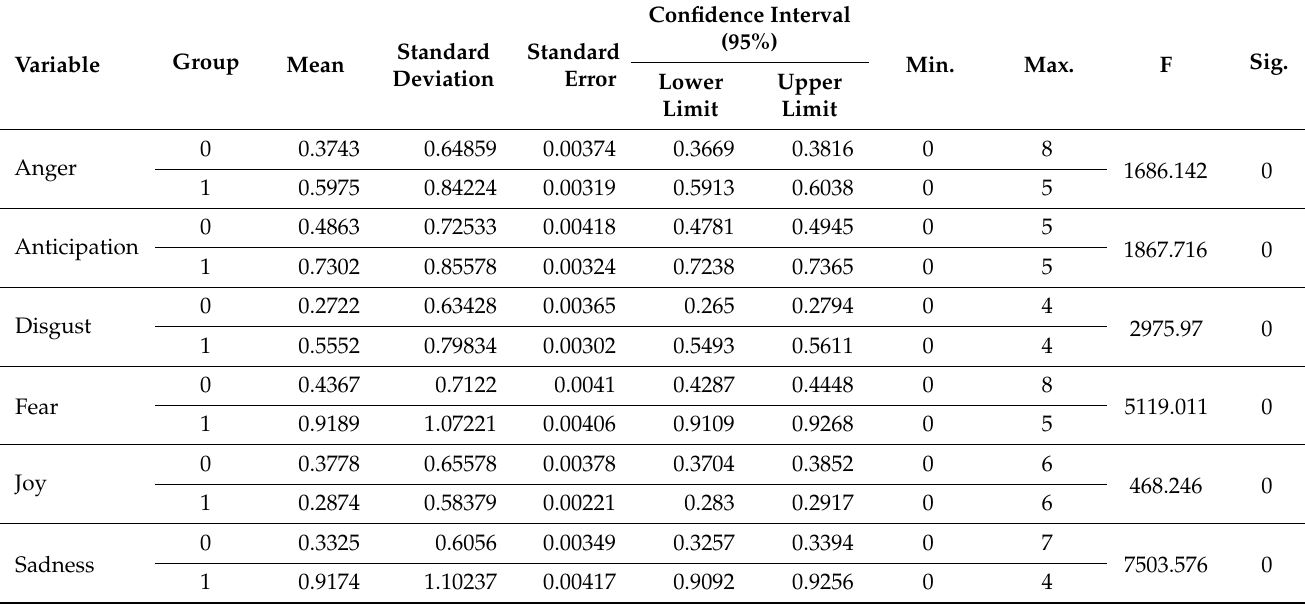
Table 6. ANOVA Period 2, for tweets (0) and retweets